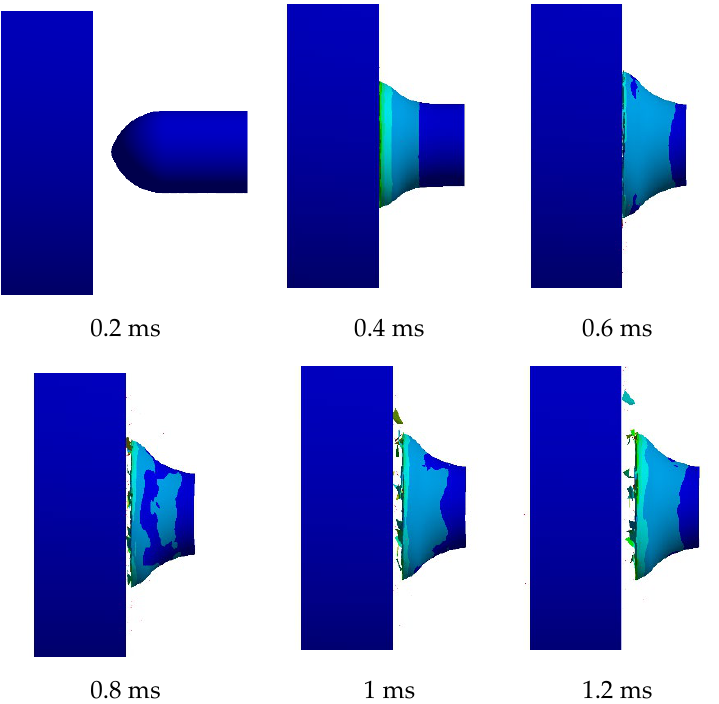
Figure 4. The AMMO 1 impact deformation evolution from 0.2 ms to 1.2 ms.